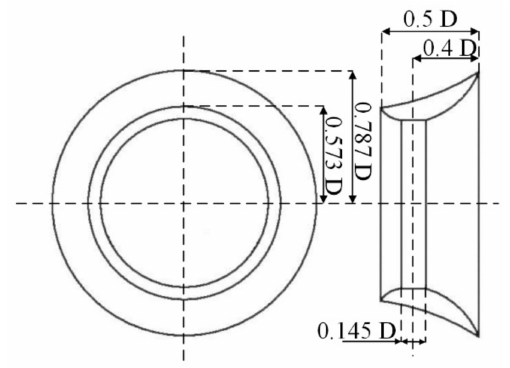
Figure 2. Dimension diagram of the duct.